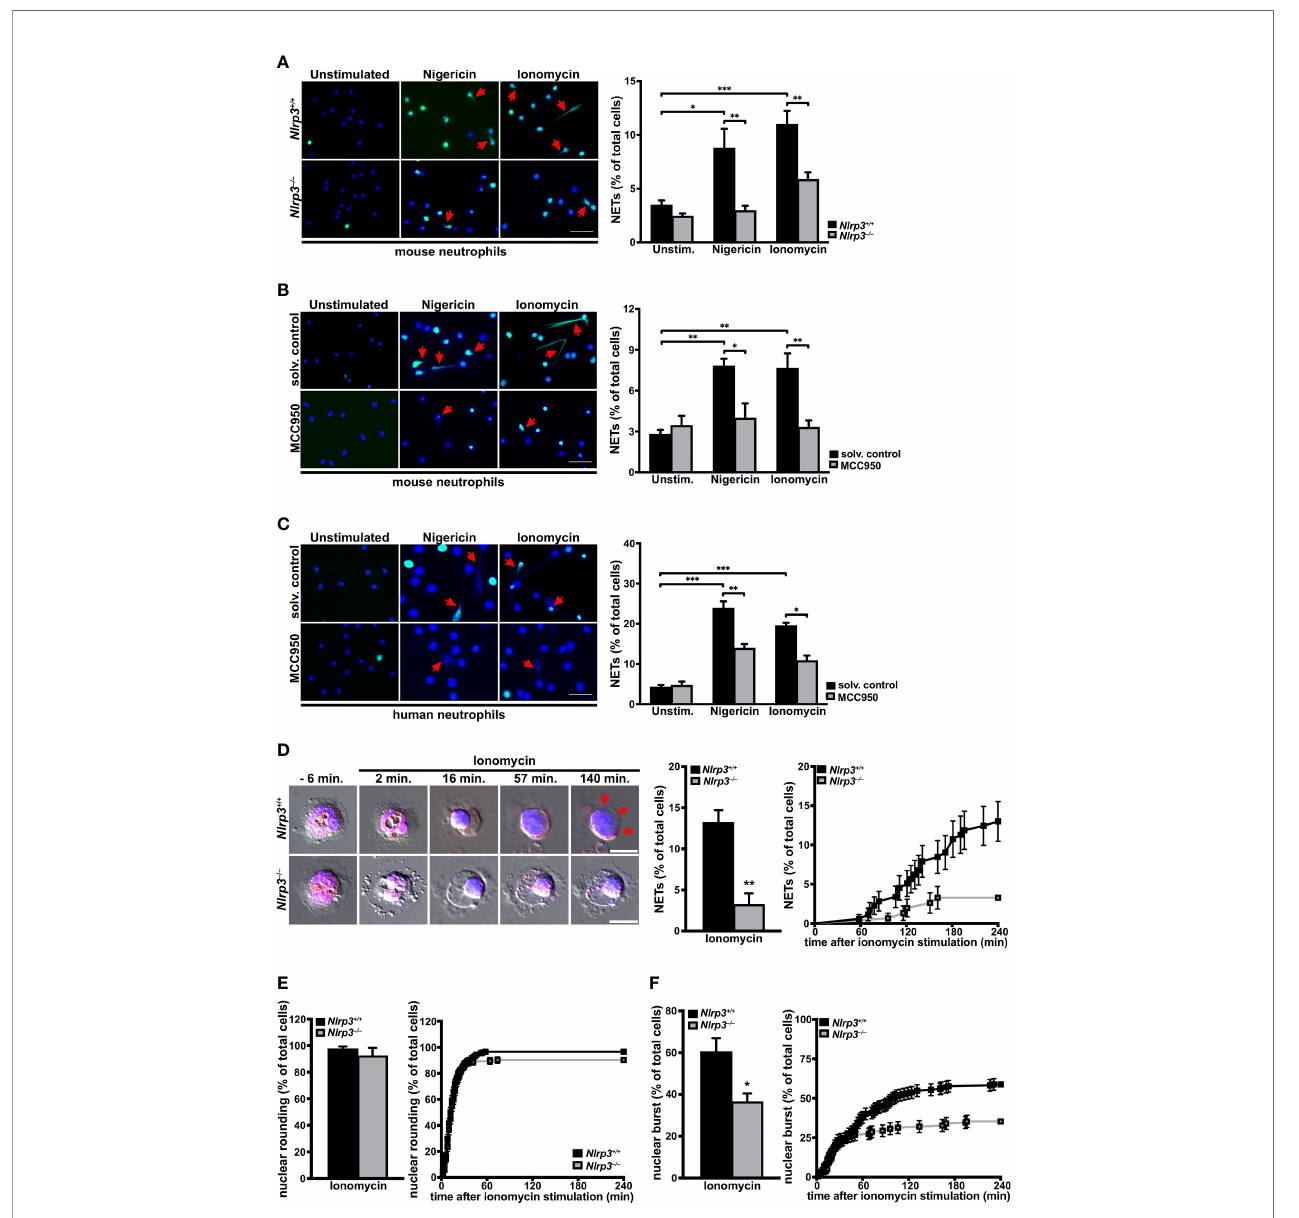
FIGURE 4 | The NLRP3 in fl ammasome promotes activation-dependent NET formation through nuclear envelope and plasma membrane breakdown in primary neutrophils. (A) Overview (left panel) and arithmetic means ± SEM (right, n=5-7 mice) of NET formation by neutrophils from wild-type ( Nlrp3 +/+ , black bars) or Nlrp3 – / – mice (grey bars) in the absence (unstimulated) or presence of nigericin (15 µM) or ionomycin (4 µM) for 4 hours. Blue, DNA (DAPI); green, H4Cit antibody stain. Red arrows indicate NETs. Scale bar equals 50 µm. * p<0.05, ** p<0.01 and *** p<0.001. (B) Overview (left panel) and arithmetic means ± SEM (right, n=5-6 mice) of NET formation in untreated (solvent control, black bars) or MCC950 pretreated (1 µM, grey bars) mouse neutrophils in the absence (unstimulated) or presence of nigericin (15 µM) or ionomycin (4 µM) for 4 hours. Blue, DNA (DAPI); green, H4Cit antibody stain. Red arrows indicate NETs. Scale bar equals 50 µm. * p<0.05 and ** p<0.01. (C) Overview (left panel) and arithmetic means ± SEM (right, n=4-8 donors) of NET formation in untreated (solvent control, black bars) or MCC950 pretreated (1µM, grey bars) human neutrophils in the absence (unstimulated) or presence of nigericin (15 µM) or ionomycin (4 µM) for 4 hours. Blue, DNA (DAPI); green, H4Cit antibody stain. Red arrows indicate NETs. Scale bar equals 50 µm. * p<0.05, ** p<0.01 and *** p<0.001. (D) Representative time-lapse differential interference contrast (DIC) spinning-disk confocal microscopy images at indicated time intervals (left panel) and arithmetic means ± SEM (center/right panel; n=5 mice) of percentage of total (middle) and time course (right) of plasma membrane rupture (NETosis) in neutrophils from wild-type ( Nlrp3 +/+ , black bars) or Nlrp3 – / – mice (grey bars) in the presence of ionomycin (4 µM). Blue, DNA (siR-DNA); red, nuclear envelope (ER-tracker). Red arrows indicate area of plasma membrane rupture. Scale bar equals 5 µm. ** p<0.01. (E) Arithmetic means ± SEM (n=5 mice) of percentage of total (left panel) and time course (right panel) of nuclear rounding in neutrophils from wild-type ( Nlrp3 +/+ , black bars) or Nlrp3 – / – mice (grey bars) in the presence of ionomycin (4 µM). (F) Arithmetic means ± SEM (n=5 mice) of percentage of total (left panel) and time course (right panel) of nuclear envelope rupture in neutrophils from wild-type ( Nlrp3 +/+ , black bars) or Nlrp3 – / – mice (grey bars) in the presence of ionomycin (4 µM). *